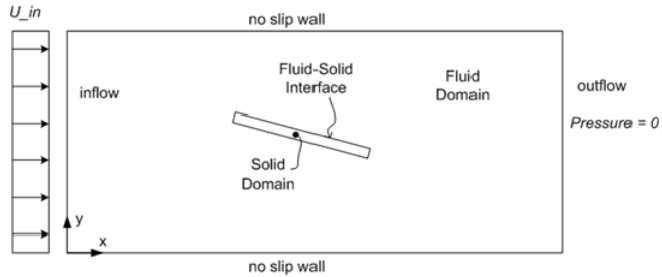
Figure 5. Domain and boundary conditions for flutter